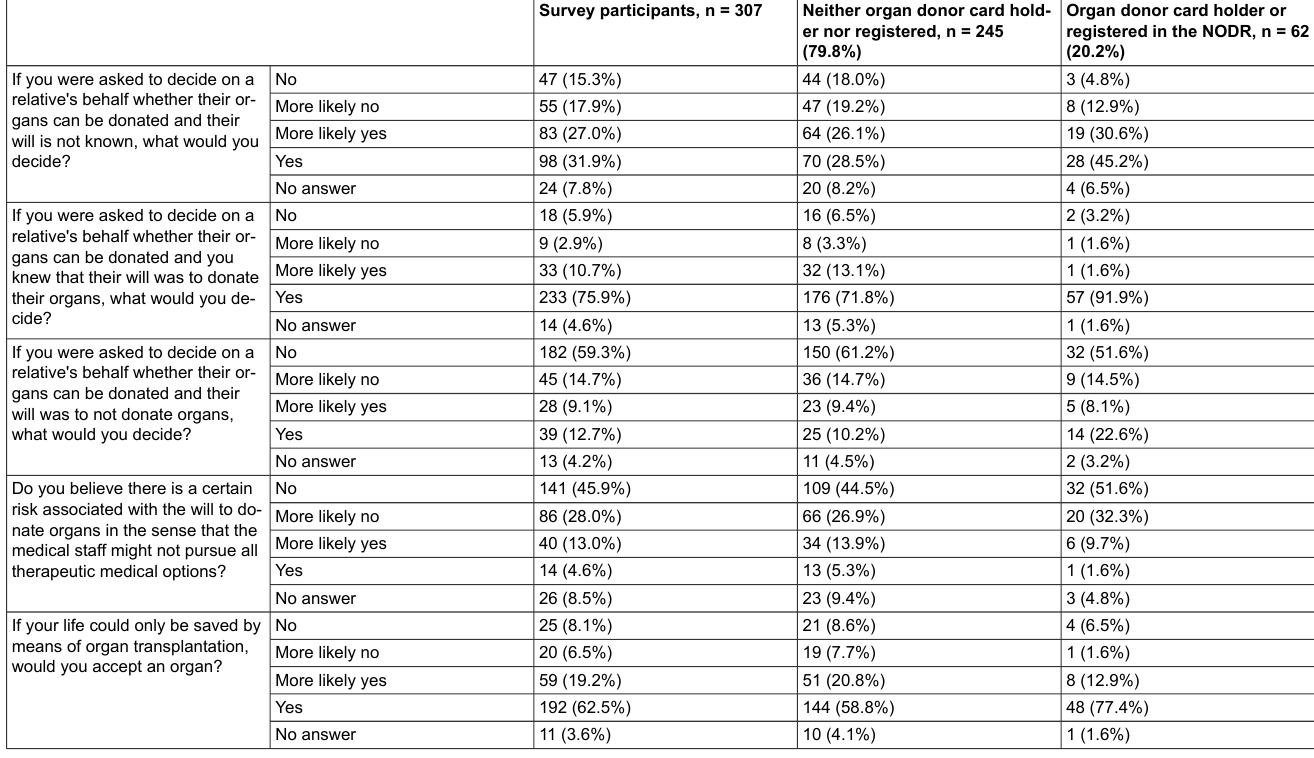
Table 7: The decision about organ donation in the event of a relative’s death.